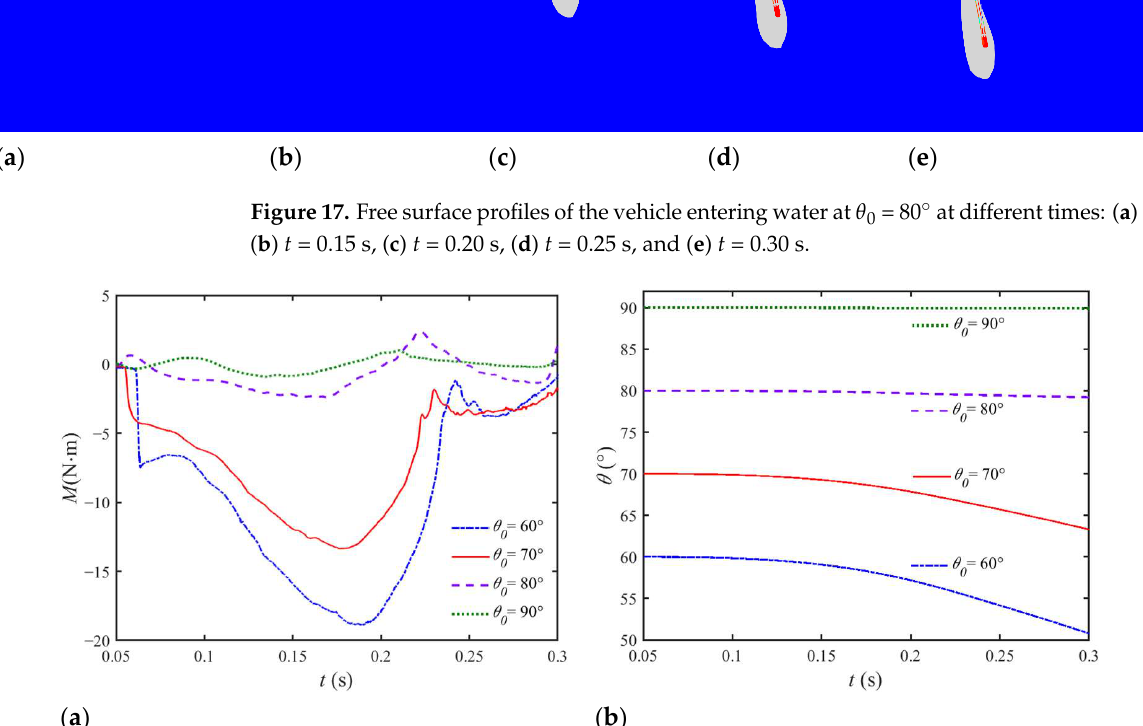
Figure 18. Comparison of time history curve of ( a ) moment and ( b ) pitch angle for the water entry of UAUV with different initial pitch angles.